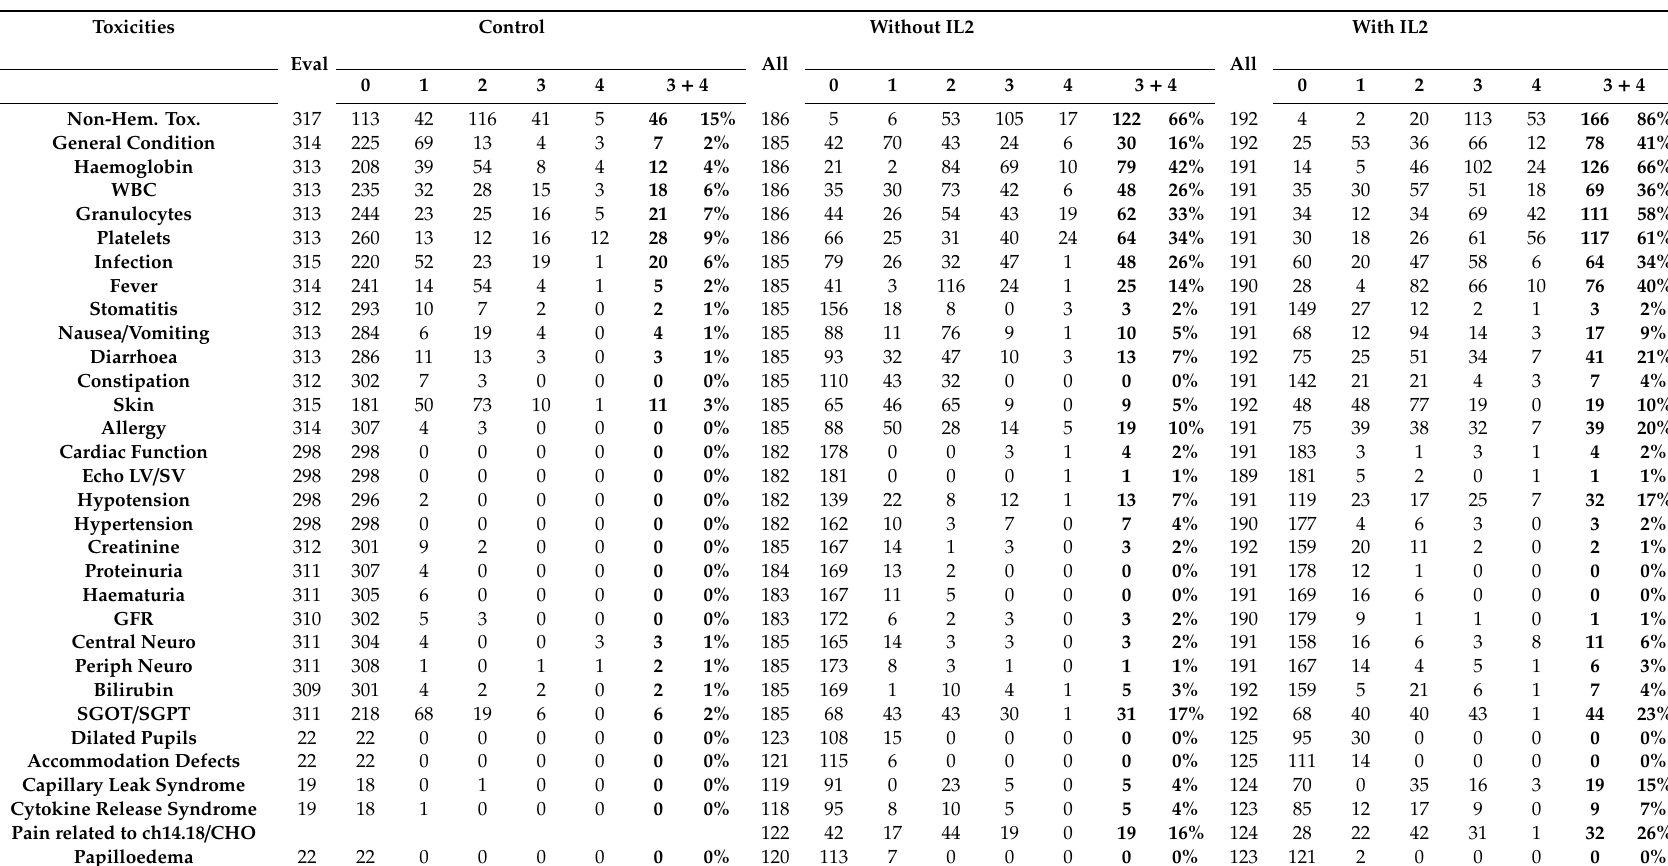
Toxicities IL-2 (interleukin 2), non-hem. tox. (non-hematological toxicities), WBC (white blood cells), ECHO LV (left ventricular) / SV (stroke volume), GFR (glomerular filtration rate), central neuro (central neurotoxicity), periph neuro (peripheral neurotoxicity) and liver enzymes: SGOT (serum-glutamat-oxalacetat-transaminase) / SGPT (serum-glutamat-pyruvat-transaminase). Columns in bold show the values for the combined grade 3 and 4 toxicities.